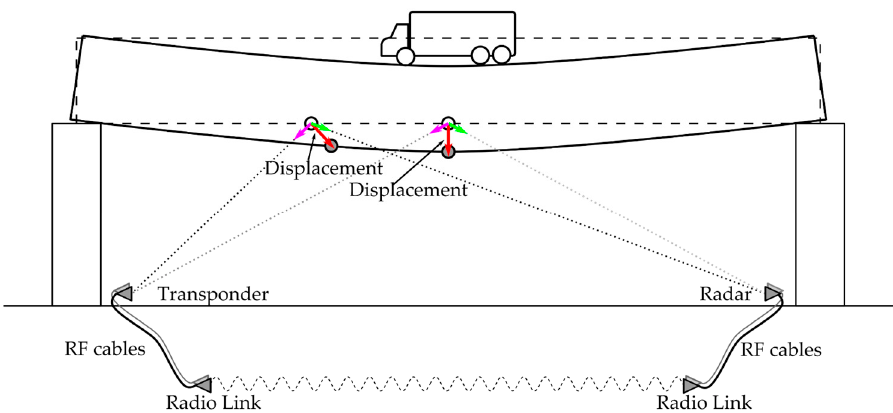
Figure 2. Working principle of multi-monostatic interferometric radar with radio link (the figure and the displacements are not in scale).